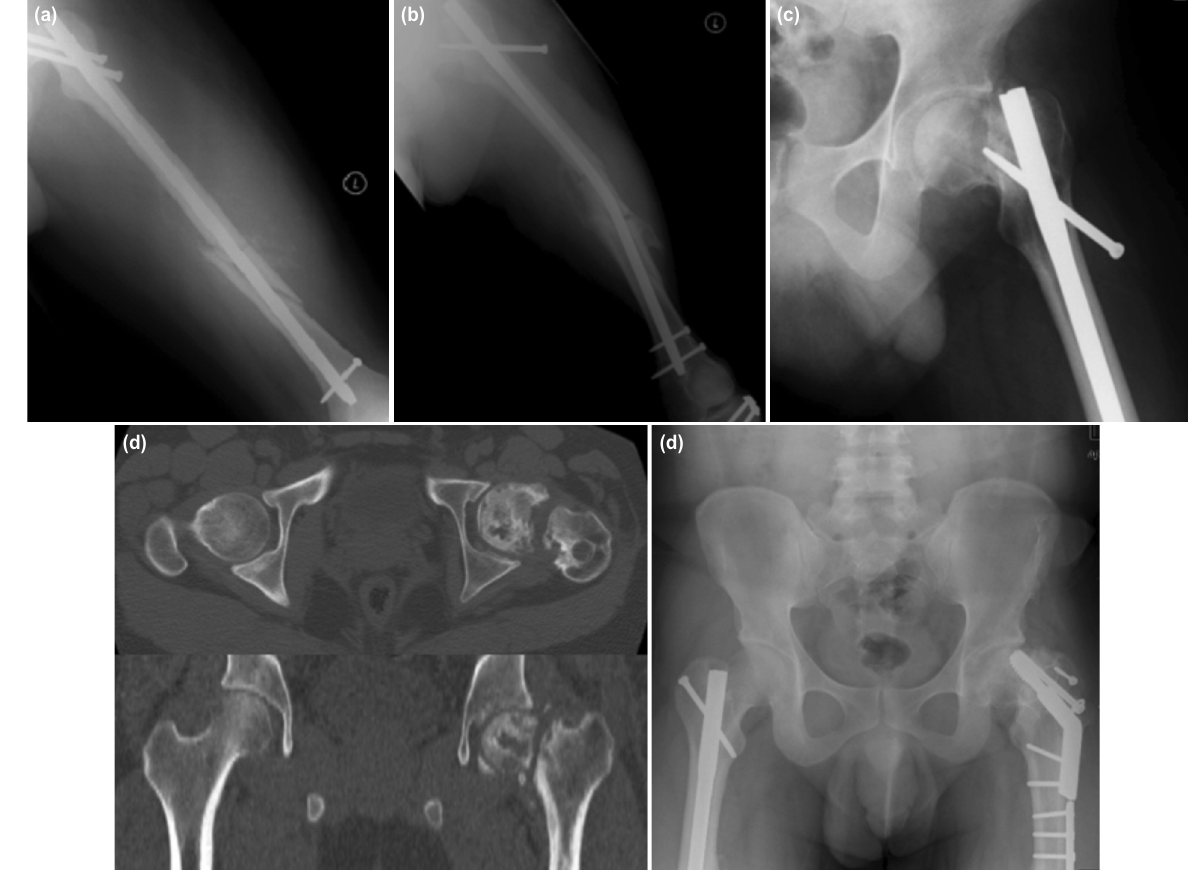
(a) Photos showing the initial reconstruction nail used to address the shaft and the femoral neck fractures in case no.3, (b) second Fig. 3: traumatic event caused implant failure to the previously fixed femoral neck fracture, (c) radiological evidence of non-union over the femoral neck, (d) imaging from the CT scan showed more obvious radiological evidences of non-union and AVN of the femoral head, (e) radiograph four years after sliding compression screw and myo-osseous trochanteric flap showed that the neck already united, however there was head AVN and shortening of the femoral neck. Patient had 2cm shortening and MRC grade 3 hip